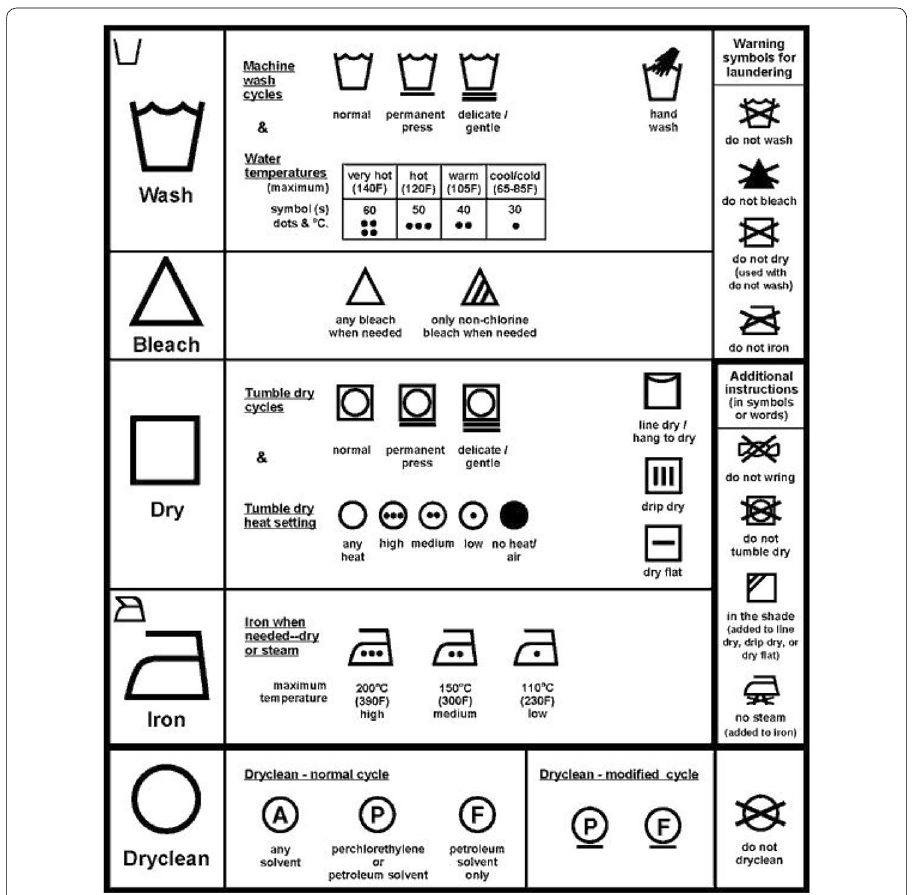
Fig. 1 Order of pictograms Source: Ginetex